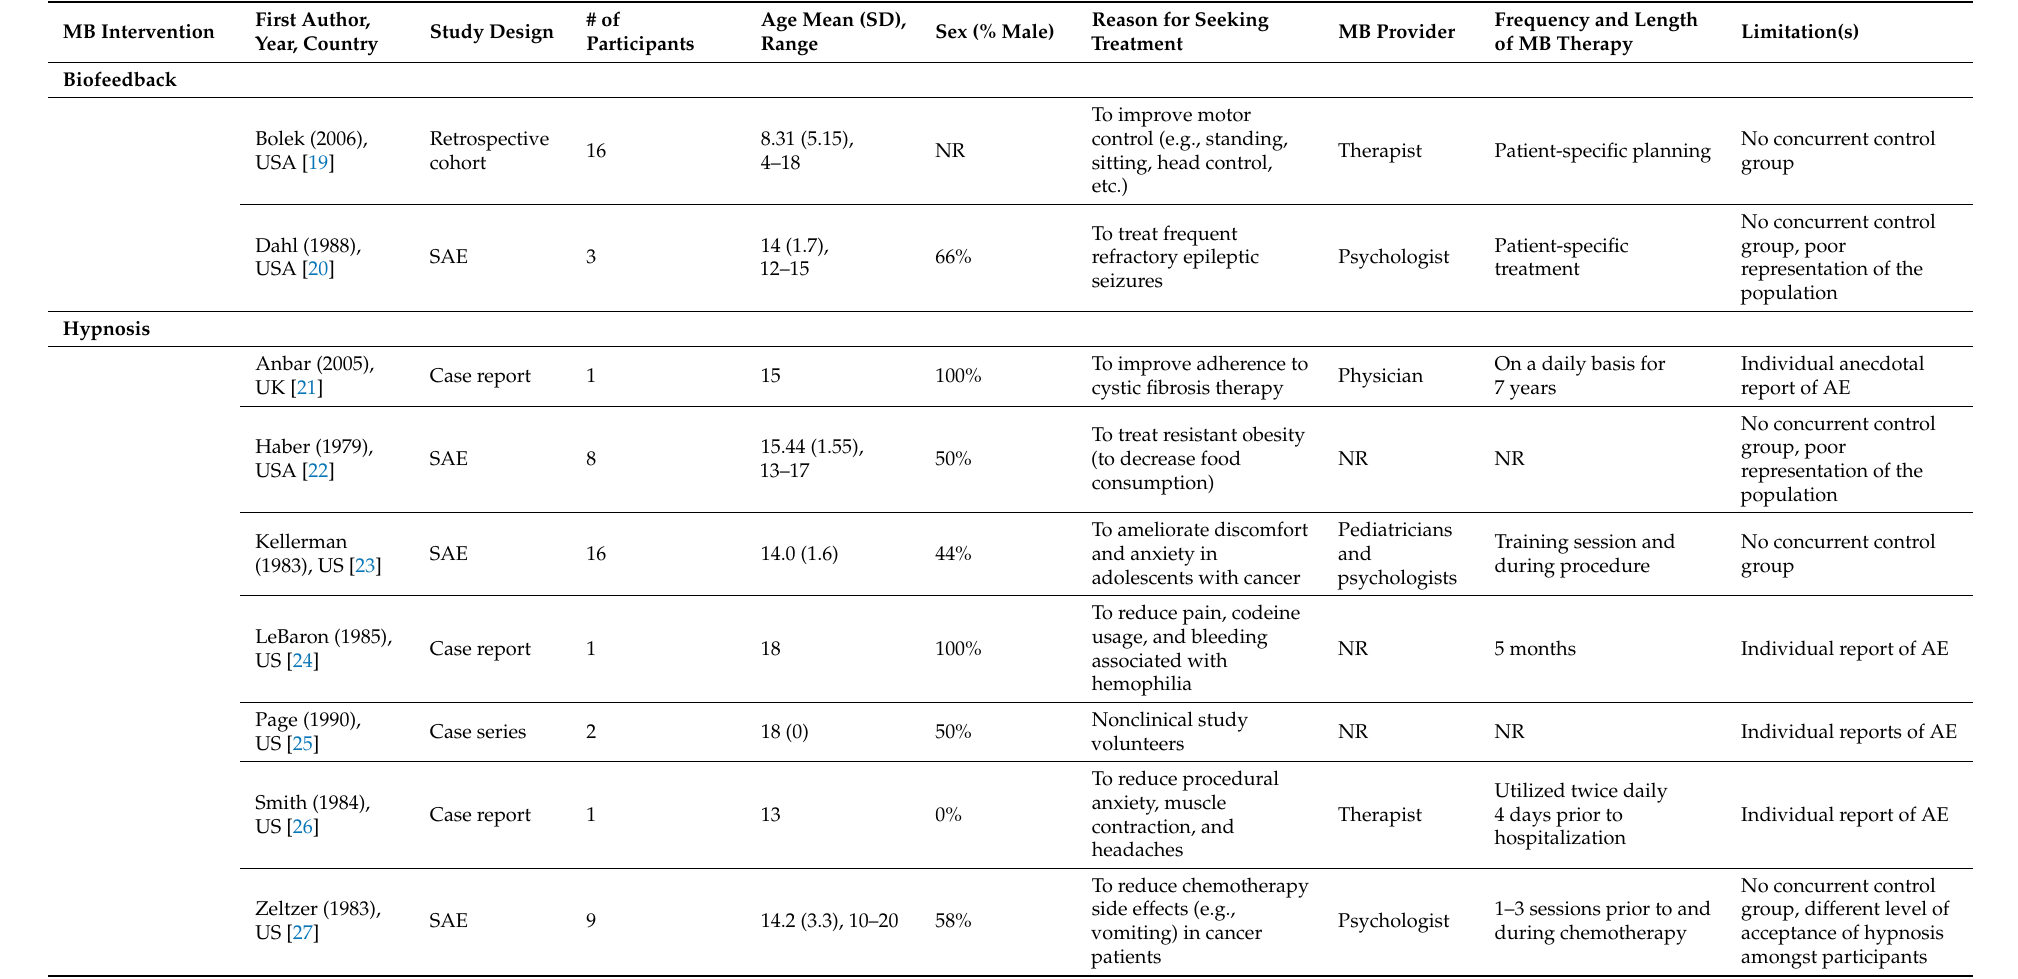
Table 1. Characteristics of the studies reporting mind-body adverse events in